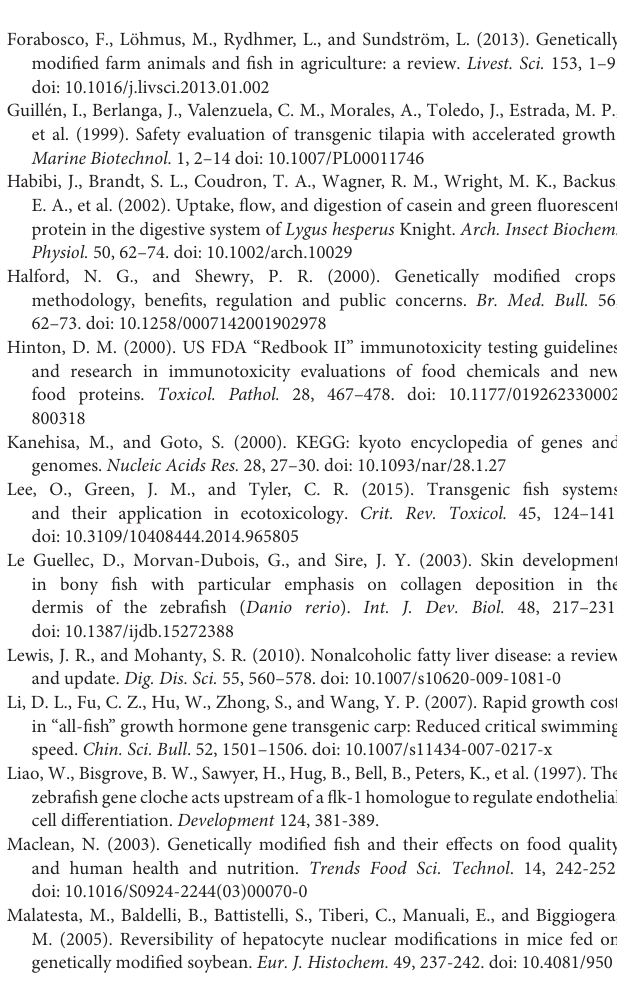
Supplementary Table 4 | Significantly deregulated genes between RFM and TFD fish. Supplementary Table 5 | Significant enrichment of GO terms by Benjamini & Hochberg multiple tests. Supplementary Table 6 | Induced KEGG signaling